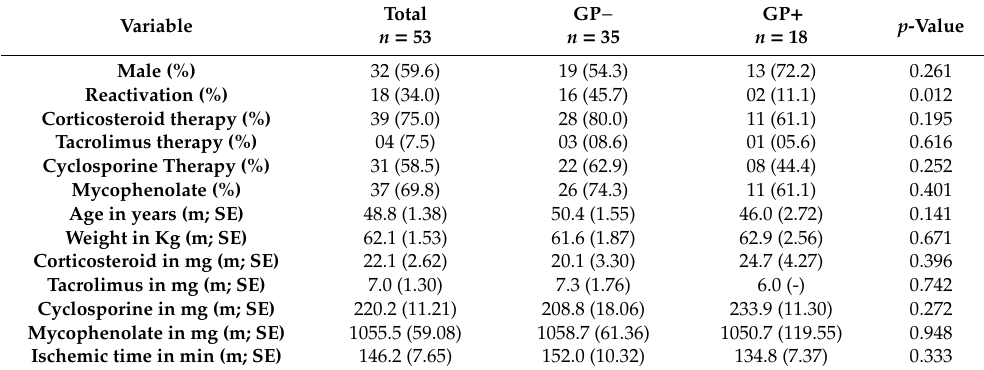
Table 1. Characteristics of patients according to benznidazole prophylactic therapy status (GP + vs. GP − ).